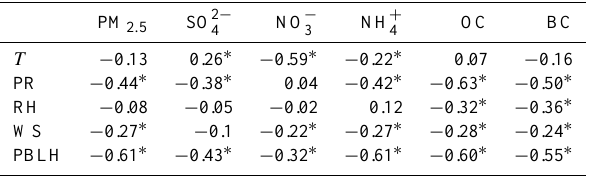
Table 4. The pattern correlation coefficients between the composite differences in aerosol concentrations (Fig. 5c) and the correspond- ing composite differences in meteorological parameters (Fig.